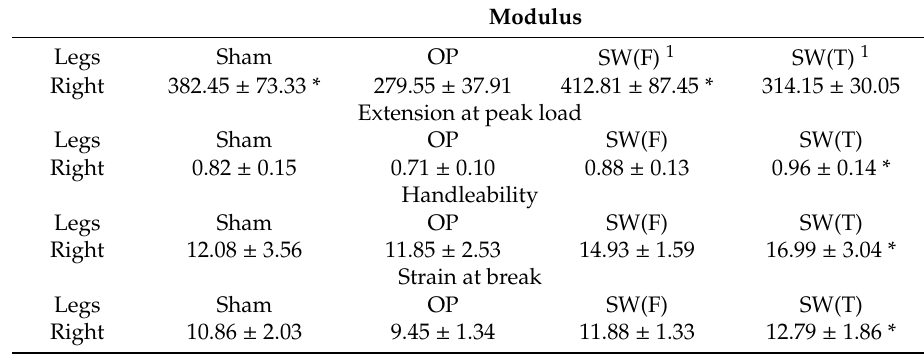
Table 1. The right femur bone was harvested for bone strength tests with modulus, extension at peak load, handleability, and strain at break.